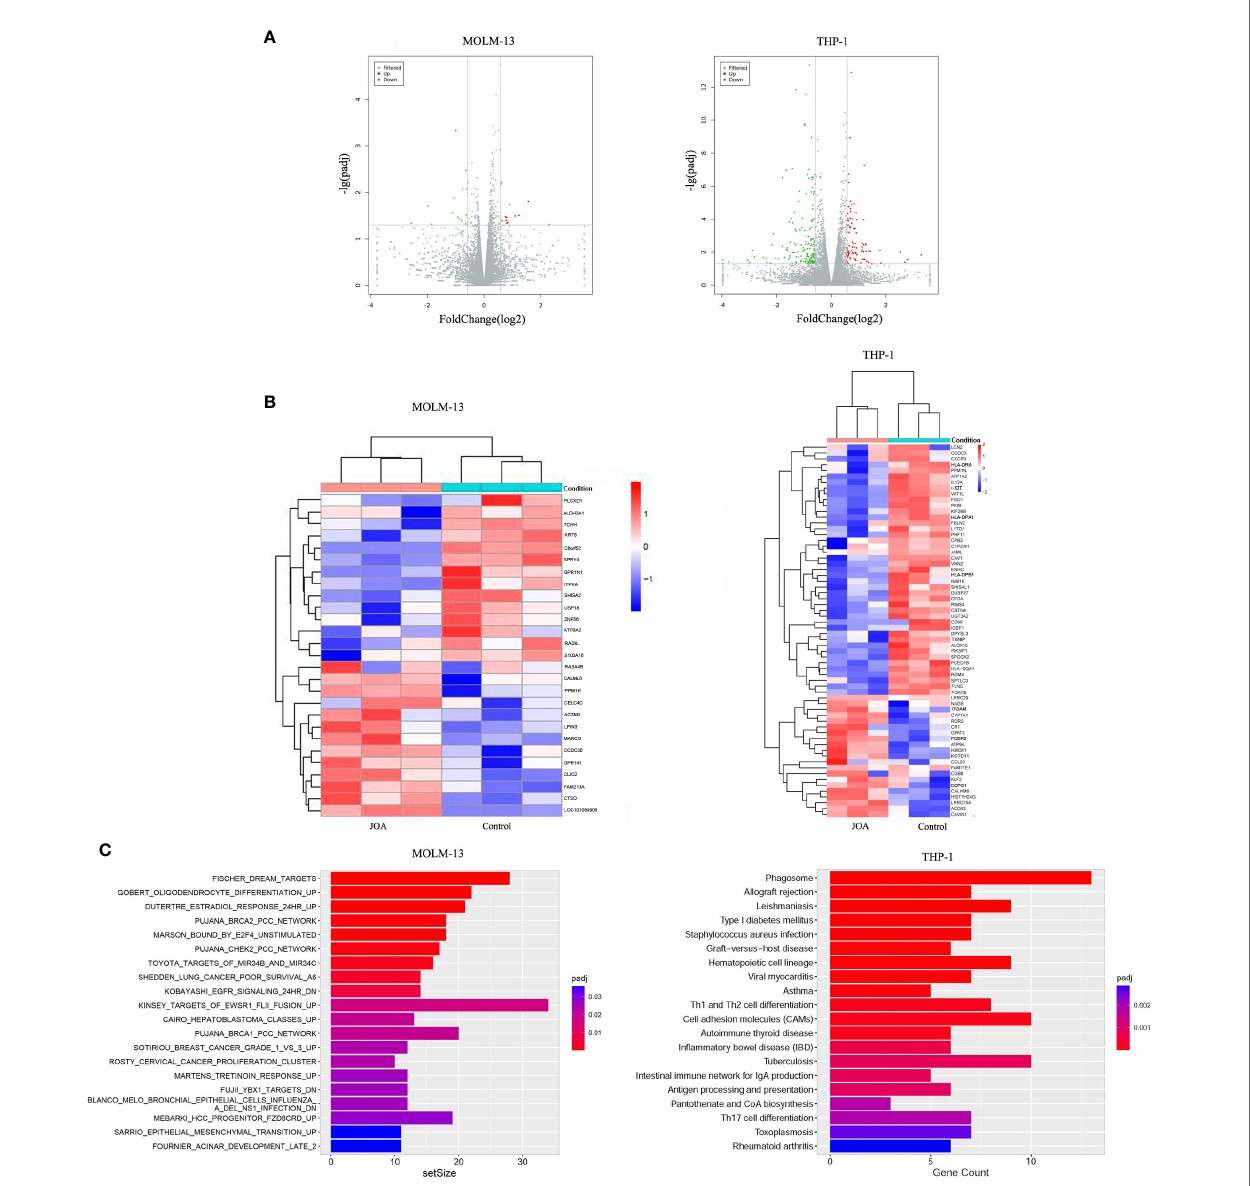
FIGURE 6 | JOA promotes cell differentiation via multiple pathways depending on cell type. MOLM-13 and THP-1 Cells were incubated with 0.5 or 2 m M JOA, respectively for 72 h. (A) Volcano plots of MOLM-13 and THP-1 cells. (B) The heatmap of DEGs. The heatmap bars from blue to red represents the expression levels of genes from lower to higher. (100 genes with p < 0.05 and |log 2 FC| >0.58 based on their p value in the THP-1 cells). (C) KEGG pathway analyses on the differentially expressed genes. MOLM-13 and THP-1 cells were incubated with 0.5, or 2 m M JOA for 72 h, respectively. The fi gures are representative of two independent